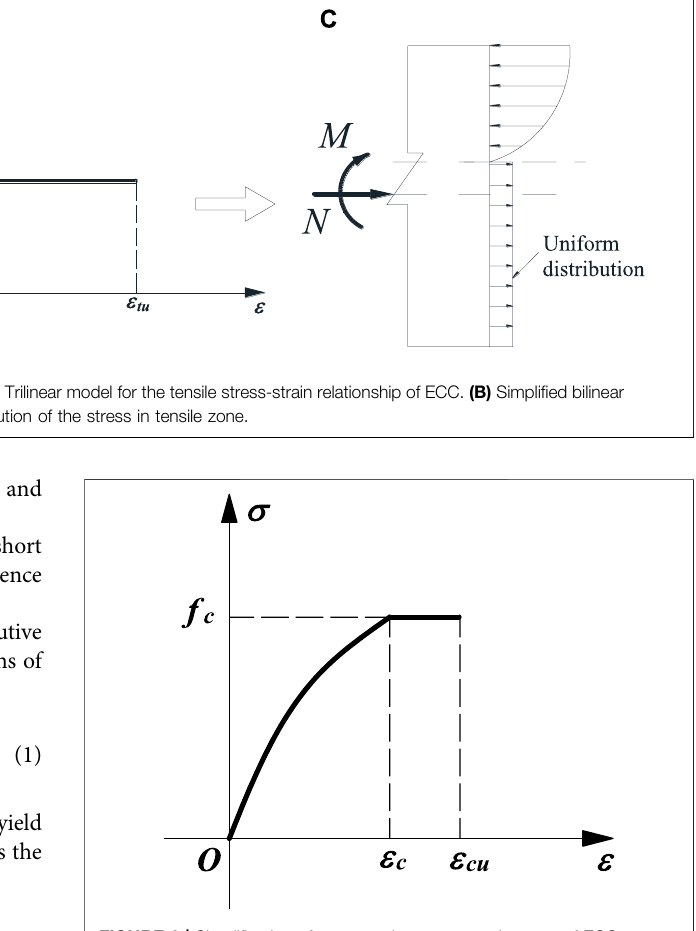
FIGURE 2 | Simpli fi cation of compressive stress – strain curve of